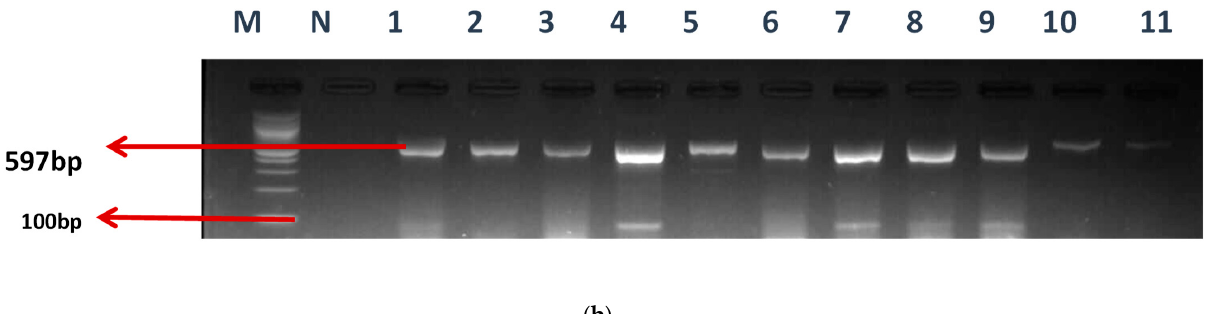
Figure 2. ( a ) The gel electrophoresis of amplicons (Expected band size 164 bp) of class 1 integron of